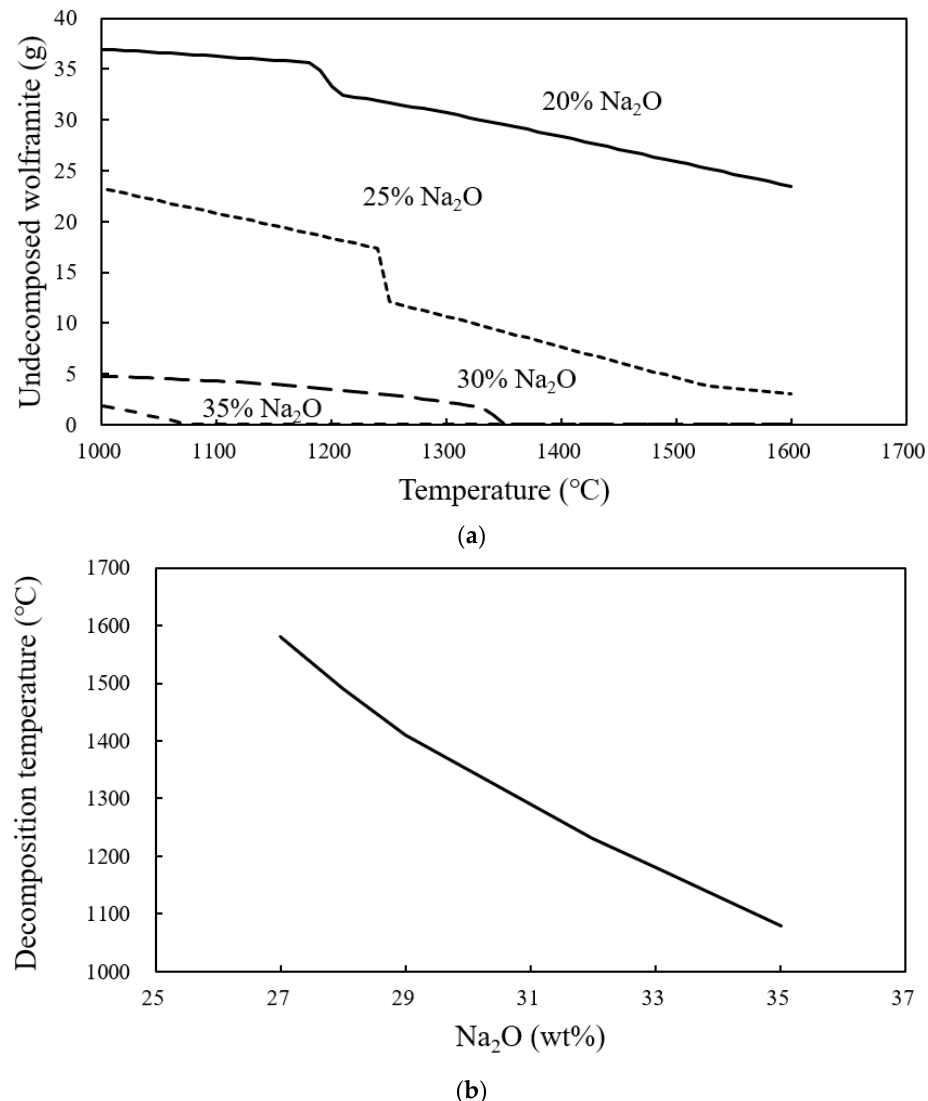
Figure 2. Effects of temperature and Na 2 O on undecomposed wolframite with 30 wt% SiO 2 , calculated by FactSage 8.2, (a) effect of temperature and Na 2 O on undecomposed wolframite, (b) lowest decomposition temperature corresponding to Na 2 O addition.